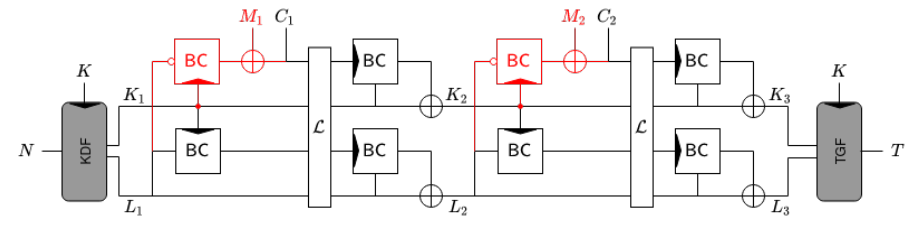
Figure 7: The LR-BC-2 mode of